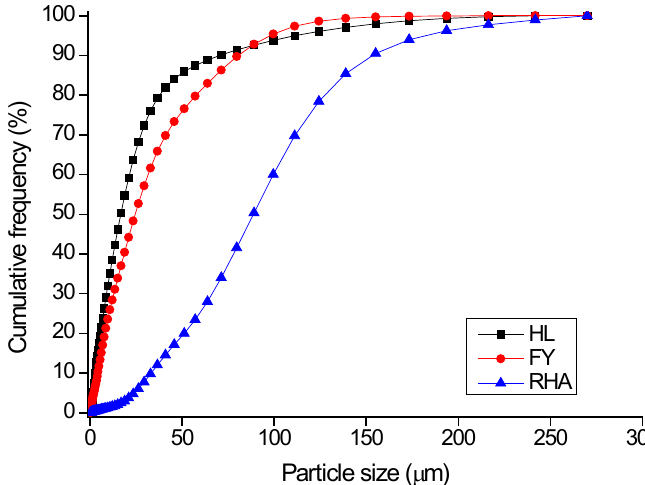
Figure 3. Particle size distribution (by volume) of raw materials: HL, FA and RHA.